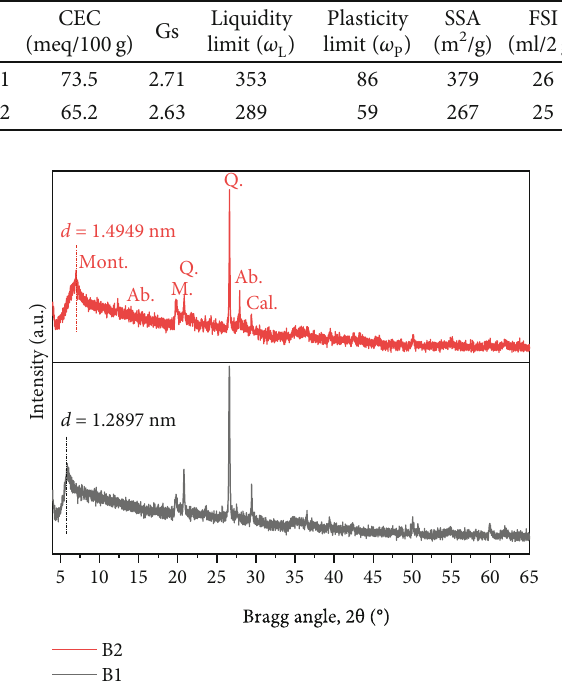
Figure 2: X-ray di ff raction patterns of soils used in this study: B1 and